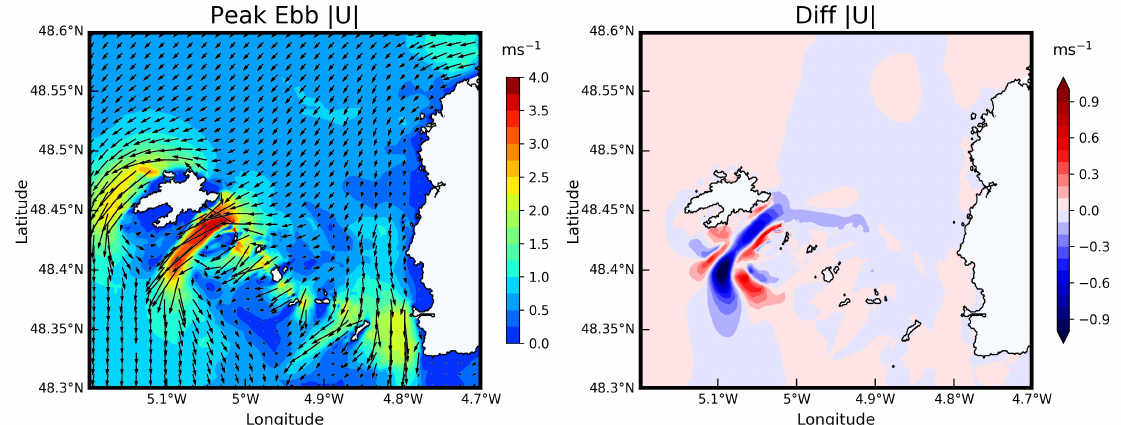
Figure 8. ( left ) Depth-averaged currents predicted without tidal stream array at peak ebb of a mean spring tide in the Ushant-Molène archipelago. ( right ) Differences in magnitude of depth-averaged velocities by integrating effects of a tidal stream array with the distributed drag method for a full energy extraction scenario. Positive and negative values account for increase and reduction of currents magnitudes with operating turbines, respectively (adapted from